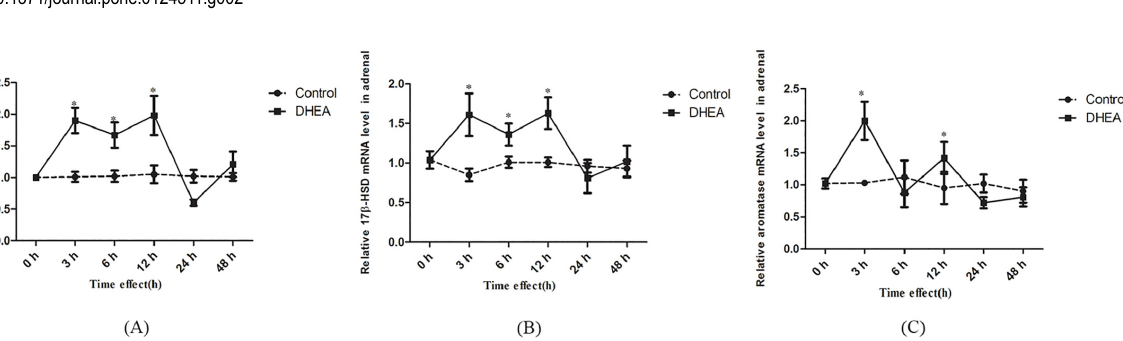
Fig 2. Effect of DHEA on 3 β -HSD (A), 17 β -HSD (B) and aromatase (C) mRNA levels in ovary in female rats. Data are expressed as means ± SE. ** P < 0 . 01 and * P < 0 . 05 , compared with the respective control group at the same time interval.